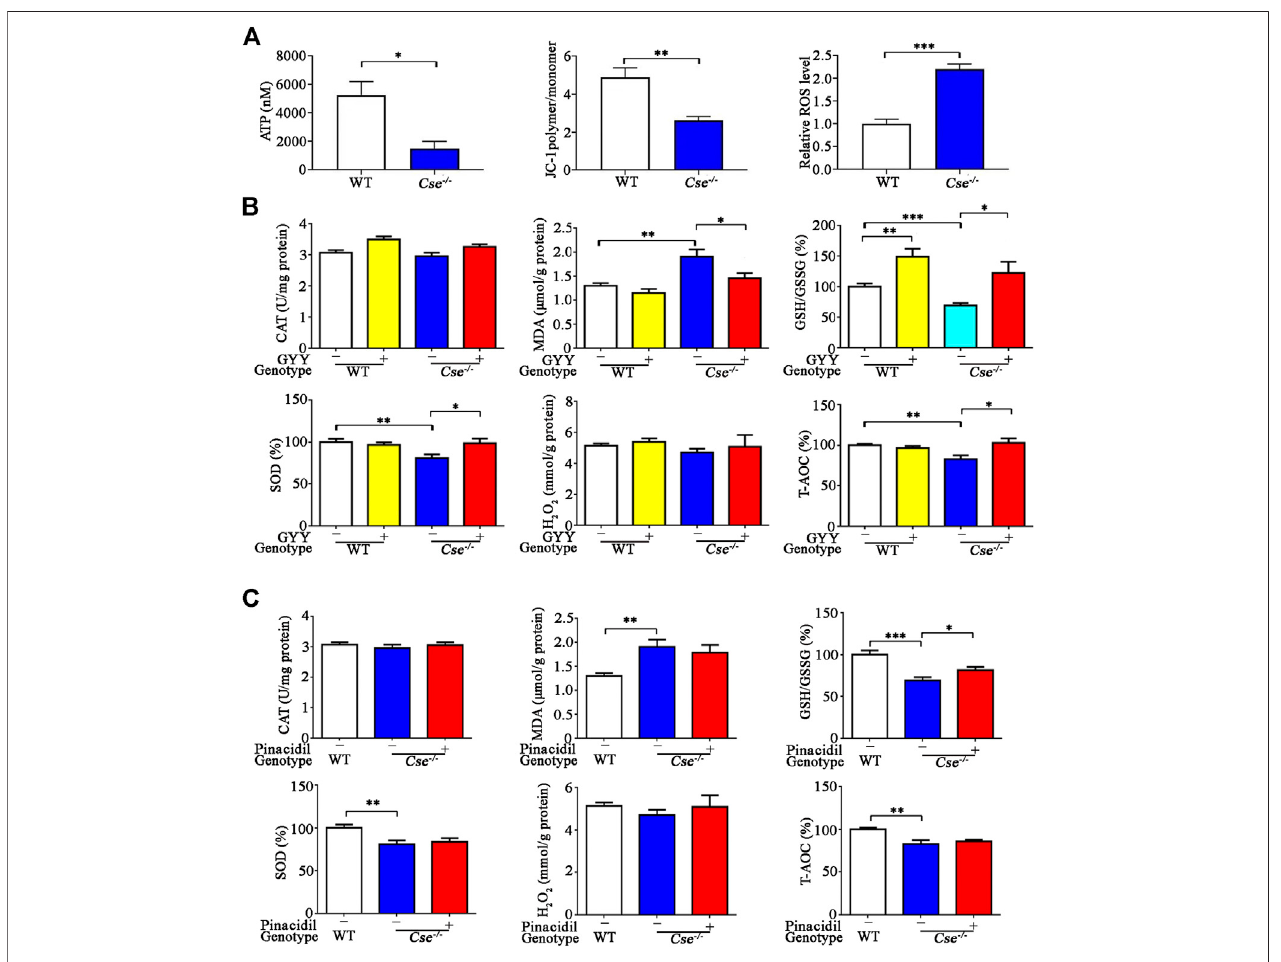
FIGURE 6 | Cse -/- mice exhibit mitochondria dysfunction and oxidative stress in lung tissues and GYY4137 treatment ameliorated oxidative stress in lung tissues. (A) , mitochondrial function in the lungs of WT and Cse -/- mice. Mitochondria were isolated from lung tissues. ATP production, membrane potential and ROS production were determined as described in Materials and Methods. (B) , parameters of oxidative status in lung tissues of WT and Cse -/- mice with GYY4137 treatment. WT and Cse − /- mice were administered with saline or GYY4137 (50mg/kg). Mice were sacri fi ced at 24h after injection. The lung tissues were collected for determination of GSH/GSSG, CAT, SOD, H 2 O 2 and T-AOC. (C) , parameters of oxidative status in lung tissues of WT and Cse -/- mice with pinacidil treatment. WT and Cse -/- mice were administered with saline or pinacidil (2.8 μ mol//kg). After 24h, the mice were sacri fi ced at 24h after injection. The lung tissues were collected for determination of GSH/ GSSG, CAT, SOD, H 2 O 2, and T-AOC. Data are expressed as mean ± SEM; n (cid:2) 8 – 11 per group; * p < 0.05, ** p < 0.01, *** p <